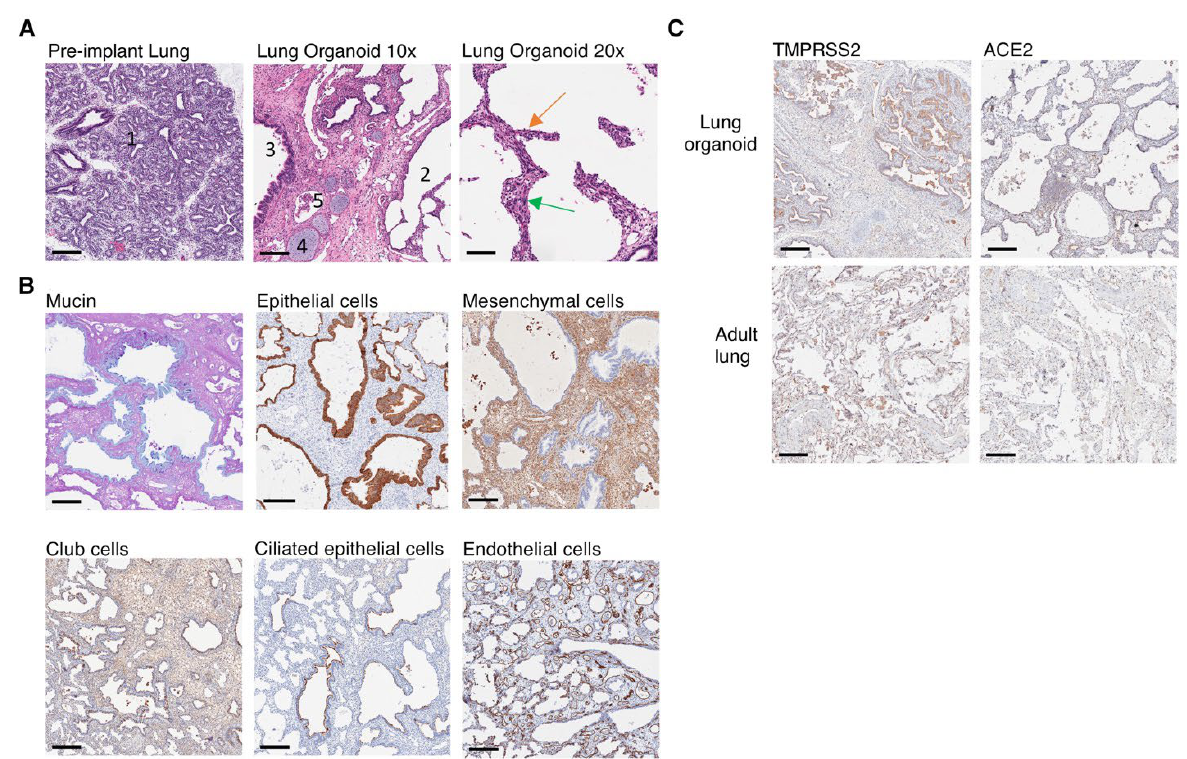
Figure 2. Human lung cells, lung structures and SARS-CoV-2 entry molecules are present in implanted lung organoids. ( A ) Pre-implant lung at glandular/canalicular stage (1). Ectopic lung implant with alveolar structures (2) and bronchial and bronchiolar structures lined by glandular ciliated respiratory epithelium (3), cartilage present in the wall of bronchi (4), and associated blood vessels ( 5) at ×10 magnification (scale bars, 200 µm). Alveolar structures in lung implant lined by type-1 (green arrow) and type-2 pneumocytes (orange arrow) visualized at ×20 magnification (scale bars, 100 µm). ( B ) Immunohistochemical staining of lung implants showing the presence of human glandular epithelium including human goblet cells (blue mucin, AB/PAS), epithelial cells (cytokeratin 19), mesenchymal cells (vimentin), club cells (CC10), ciliated glandular epithelium (tubulin) and endothelial cells (CD34). ( C ) Expression of ACE2 and TMRPSS2 in implanted lung organoid compared to a healthy lung section from a 71-year-old adult male. ( B , C ) Positive staining = brown unless otherwise indicated, ×10 magnification (scale bars, 200 µm). Images represent n = 4 at 15 wps.